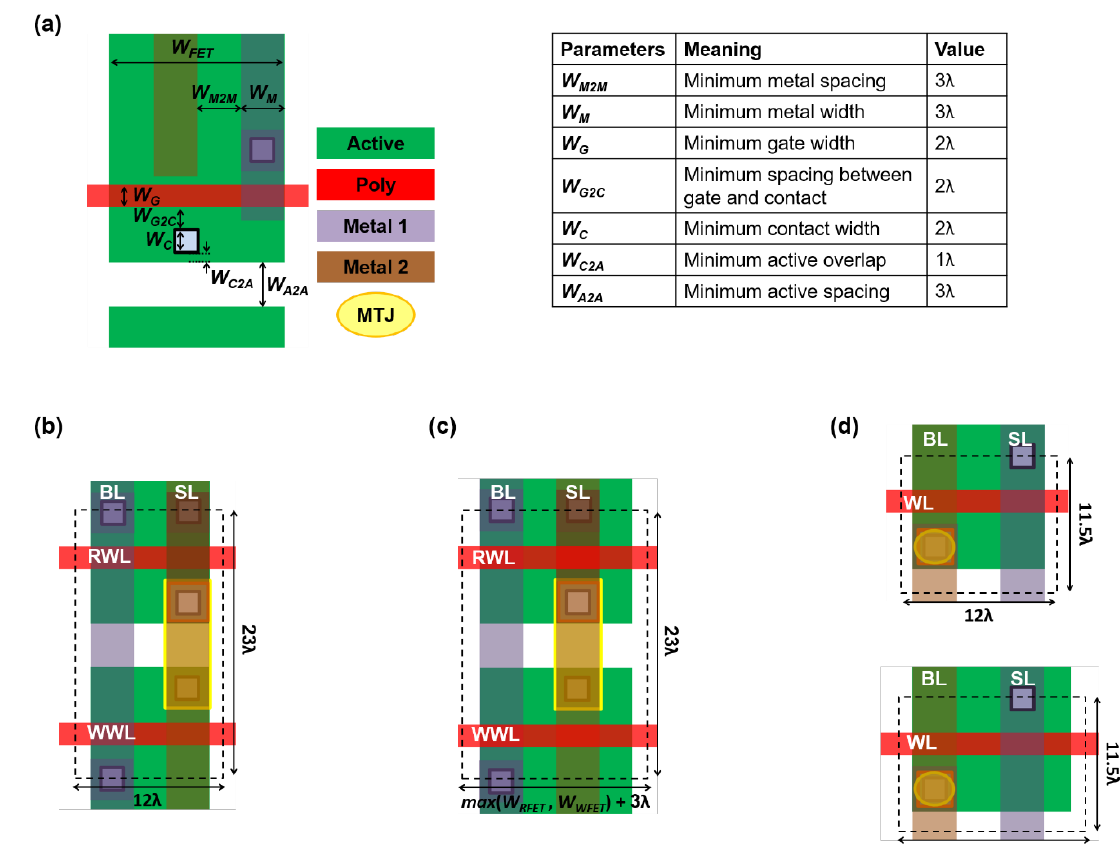
Figure 3. ( a ) Parameters for layout design rules; ( b ) conventional SOT-MRAM when max ( W RFET , W WFET ) is smaller than 9 λ ; ( c ) conventional SOT-MRAM when max ( W RFET , W WFET ) is greater than 9 λ ; ( d ) conventional STT-MRAM when its access transistor W FET is smaller than 9λ [top] or greater than 9λ [bottom].